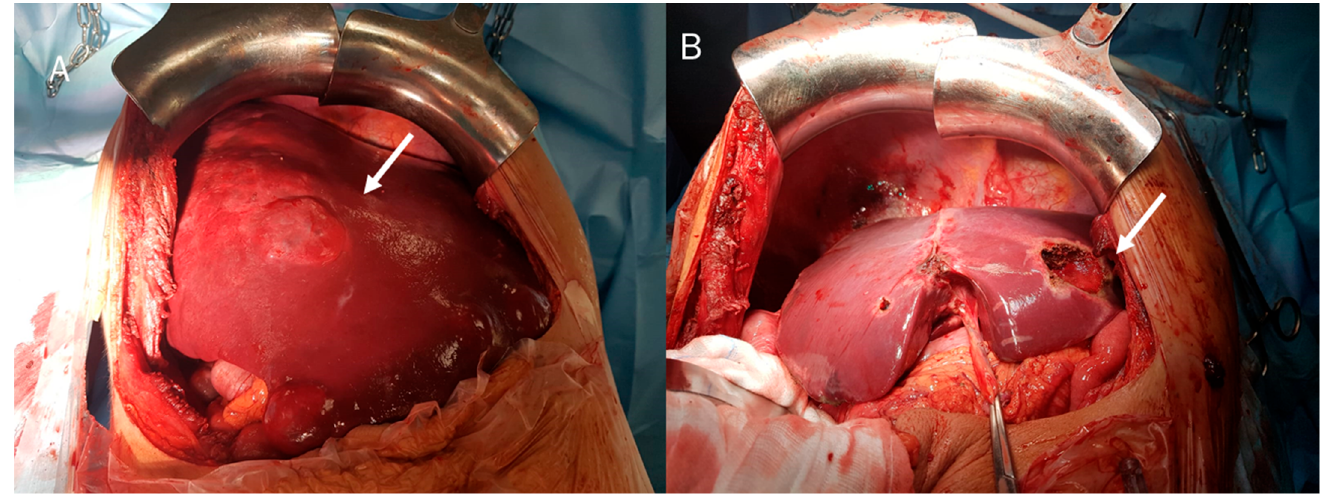
Figure 5. ( A ) cHCC-CCA on II hepatic segment during surgical resection (arrow); and ( B ) post- surgical resection features (arrow).